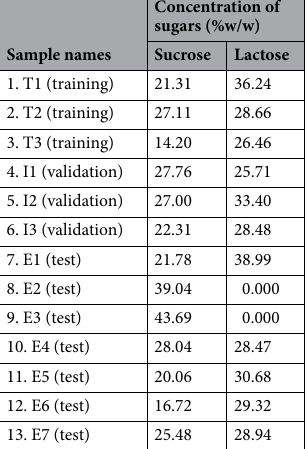
Table 1. Concentrations of sucrose and lactose in milk tablet